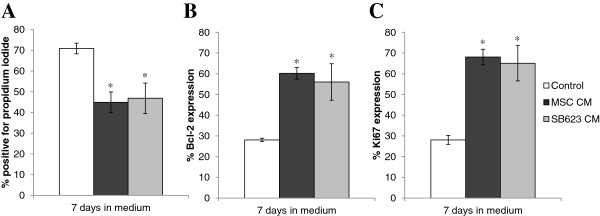
SB623 cell- and MSC-conditioned medium supports HUVEC survival and proliferation. Following “starvation”, HUVECs were cultured for 7 days with OptiMEM conditioned by either MSCs or SB623 cells or unconditioned OptiMEM (“Control”). A) Compared to unconditioned medium, conditioned medium (CM) led to a significant decrease in dead/dying propidium iodide-positive HUVECs. B) There was a significant increase in expression of Bcl-2, indicating that factors secreted by MSCs or SB623 cells are anti-apoptotic for HUVECs. C) Compared to unconditioned medium, CM led to a significant increase in Ki67-positive proliferating HUVECs. Mean ± SD; *p < 0.05 compared to OptiMEM only Control group.